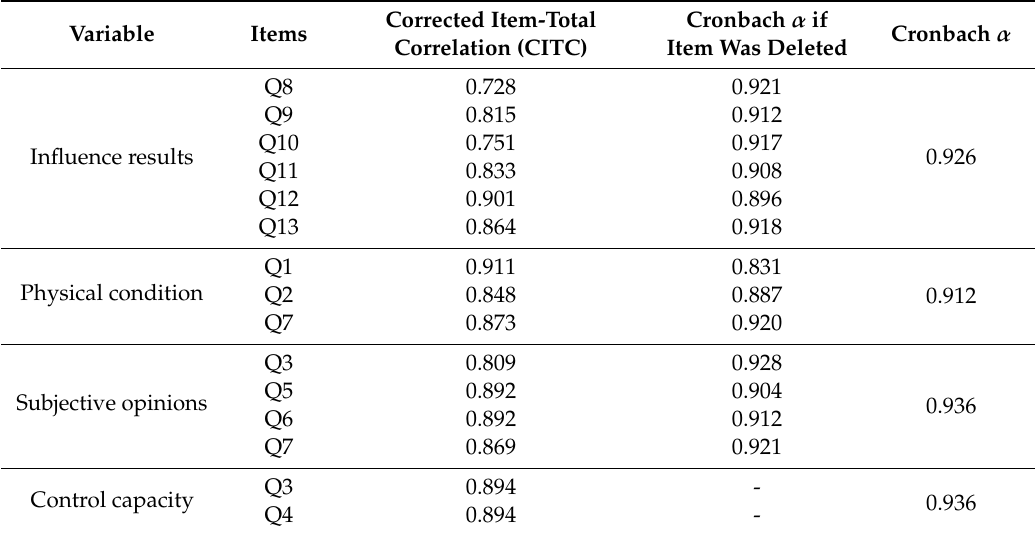
Table 3. Results of data reliability